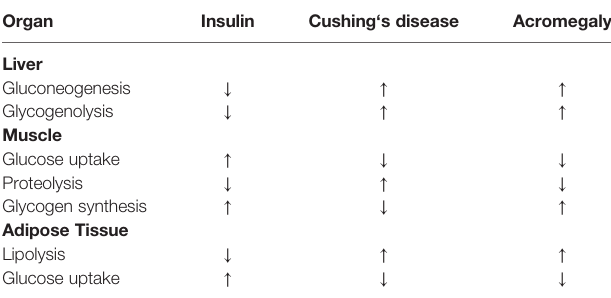
TABLE 1 | Metabolic effects of insulin and alterations in Cushing ‘ s disease and